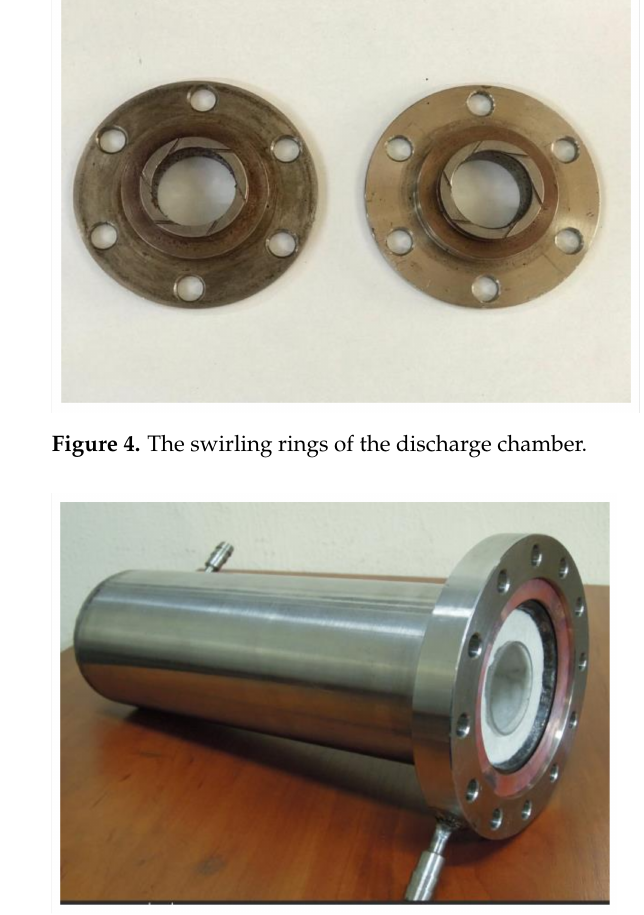
Figure 5. Quartz-lined post-discharge reactor with water-cooled shell and